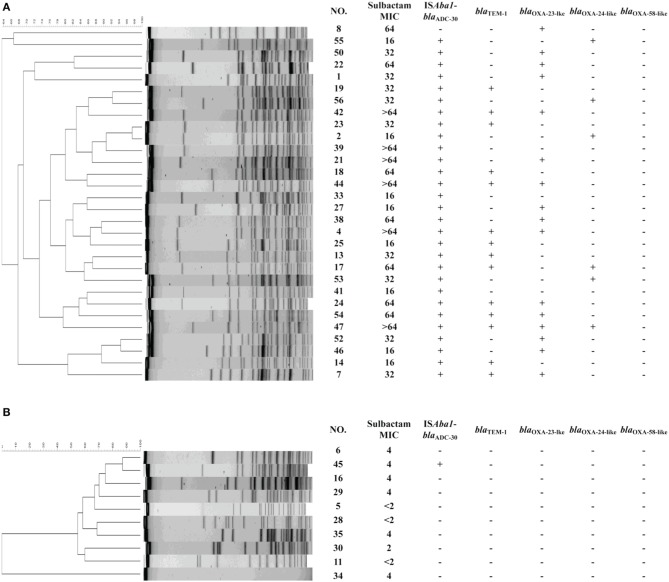
Molecular characteristics of randomly selected Acinetobacter baumannii from the Taiwan Surveillance of Antimicrobial Resistance (TSAR) program, 2002–2010. The results of pulsed-field gel electrophoresis are shown, followed by the minimal inhibitory concentrations (MICs), and the presence of ISAba1-blaADC-30, blaTEM-1, ISAba1-blaOXA-23-lke, blaOXA-24-like, and blaOXA-58-like in the (A) sulbactam-resistant strains and (B) sulbactam-susceptible strains.